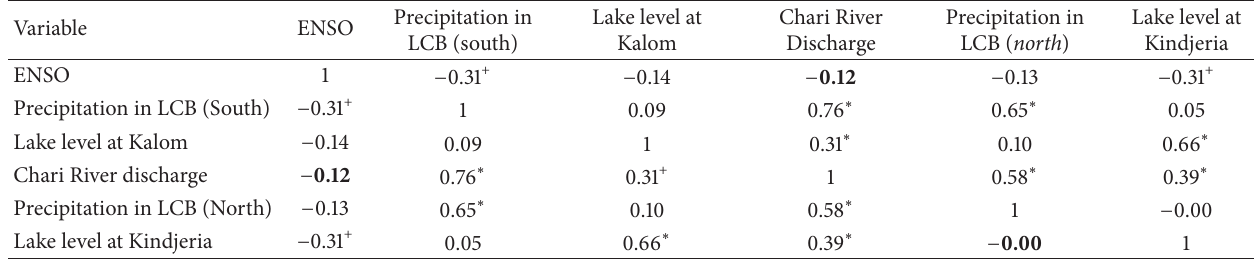
Table 1: Correlations between rainfall (in northern and southern parts of the LCB), Chari River discharge, lake level (at Kalom and Kindjeria), and ENSO in matrix form ( ∗ and + denote significance at 99.5% and 95% confidence levels, respectively).